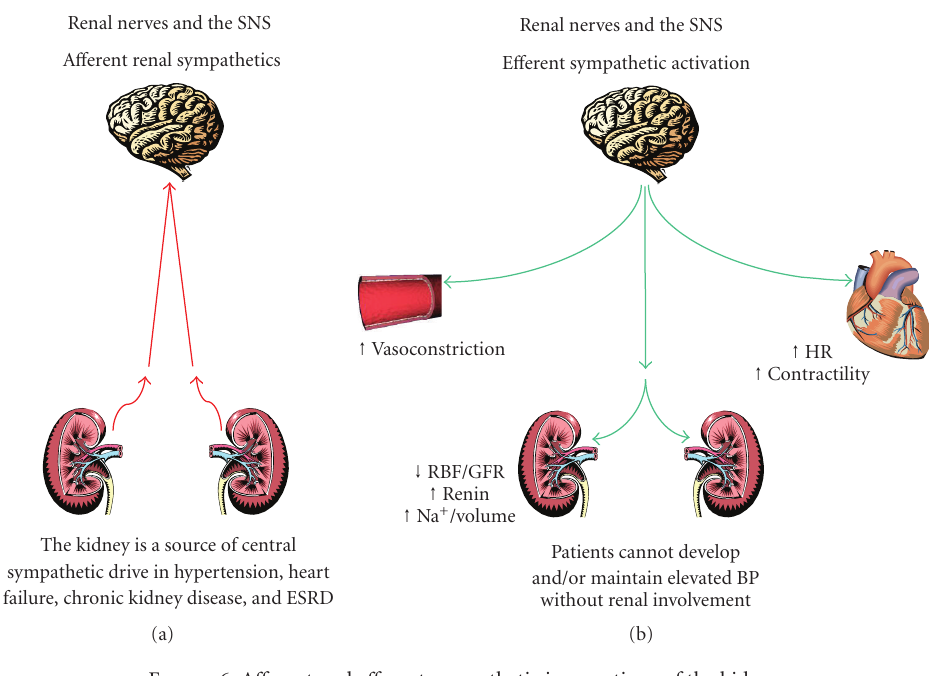
Figure 6: A ff erent and e ff erent sympathetic innervations of the kidney.